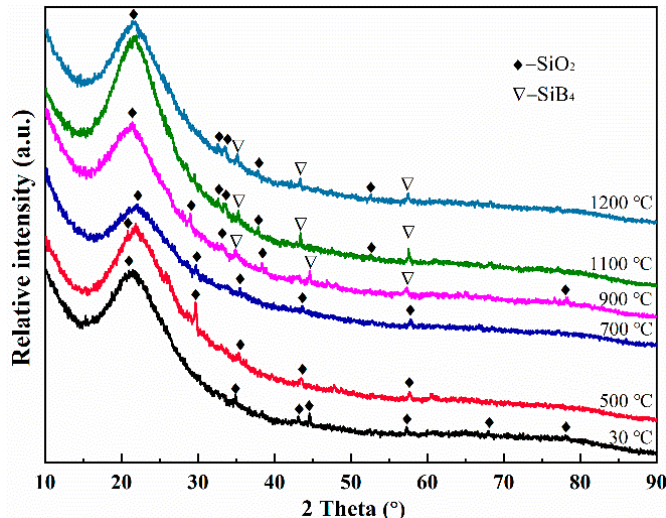
Figure 5. XRD patterns of samples inserted at different temperatures.